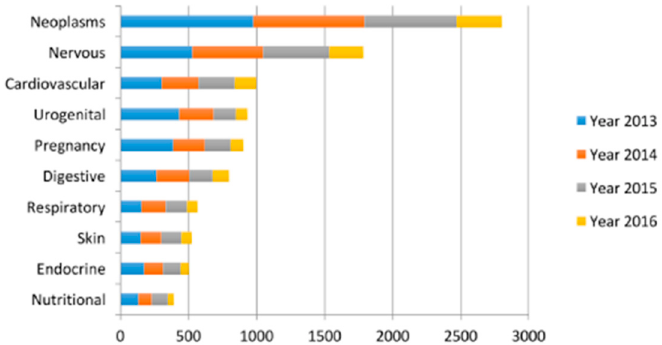
Figure 3. The leading disease types considered in the artificial intelligence literature (PubMed) [3].